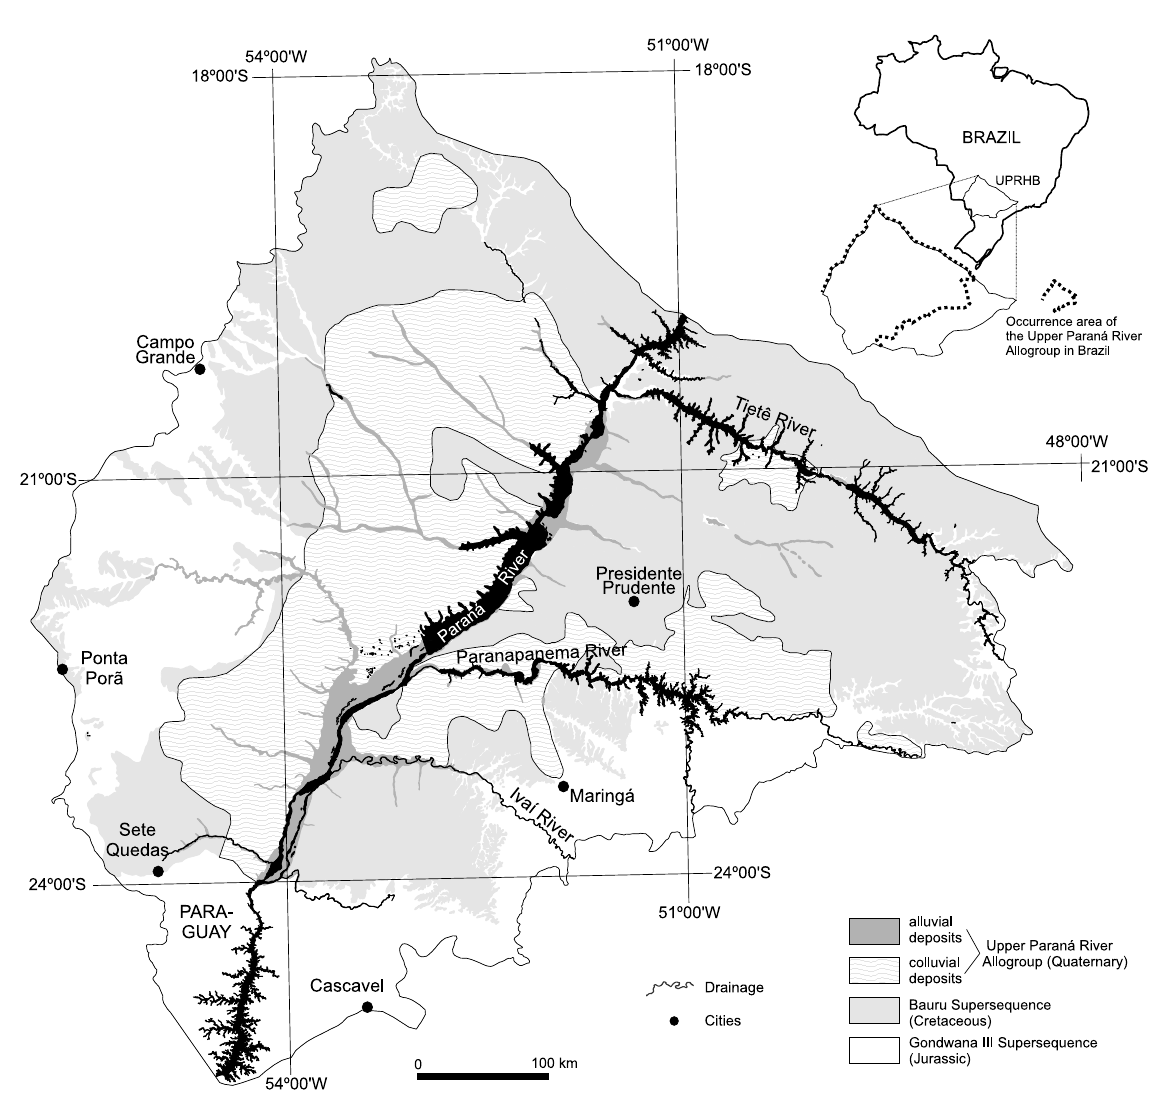
Fig. 2 – Geologic map of the occurrence of the Upper Paraná River Allogroup in the UPRHB according to Sallun et al.